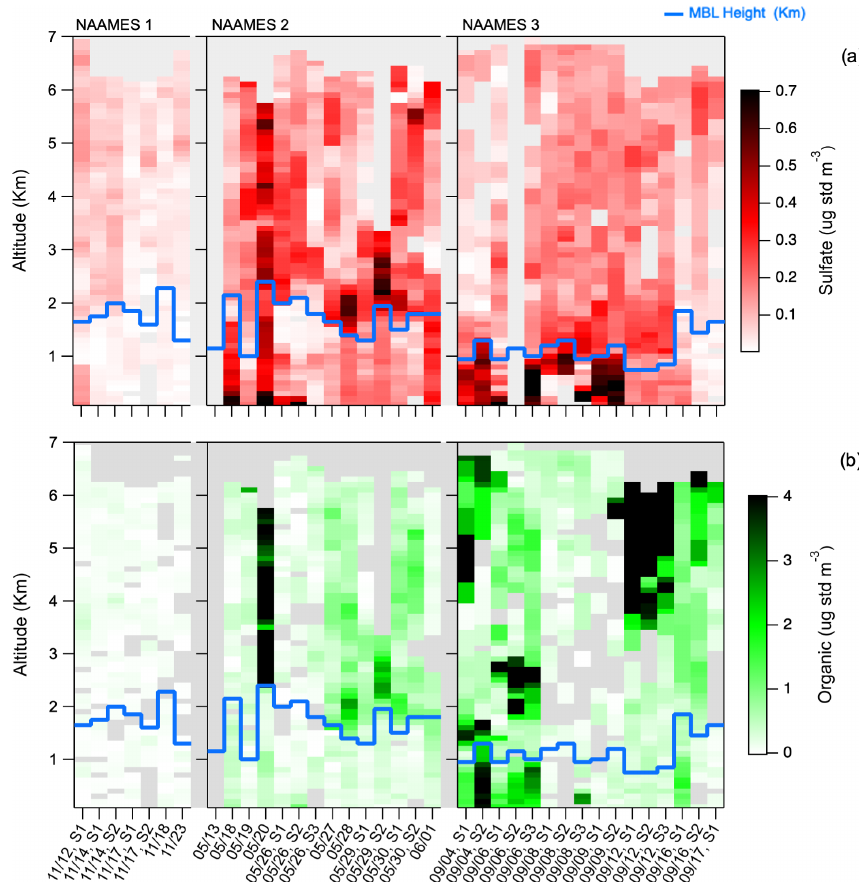
Figure 5. Vertical profile non-refractory aerosol chemical composition of aerosol particles during NAAMES-1, NAAMES-2, and NAAMES- 3: sulfate (a) , total organics (b)